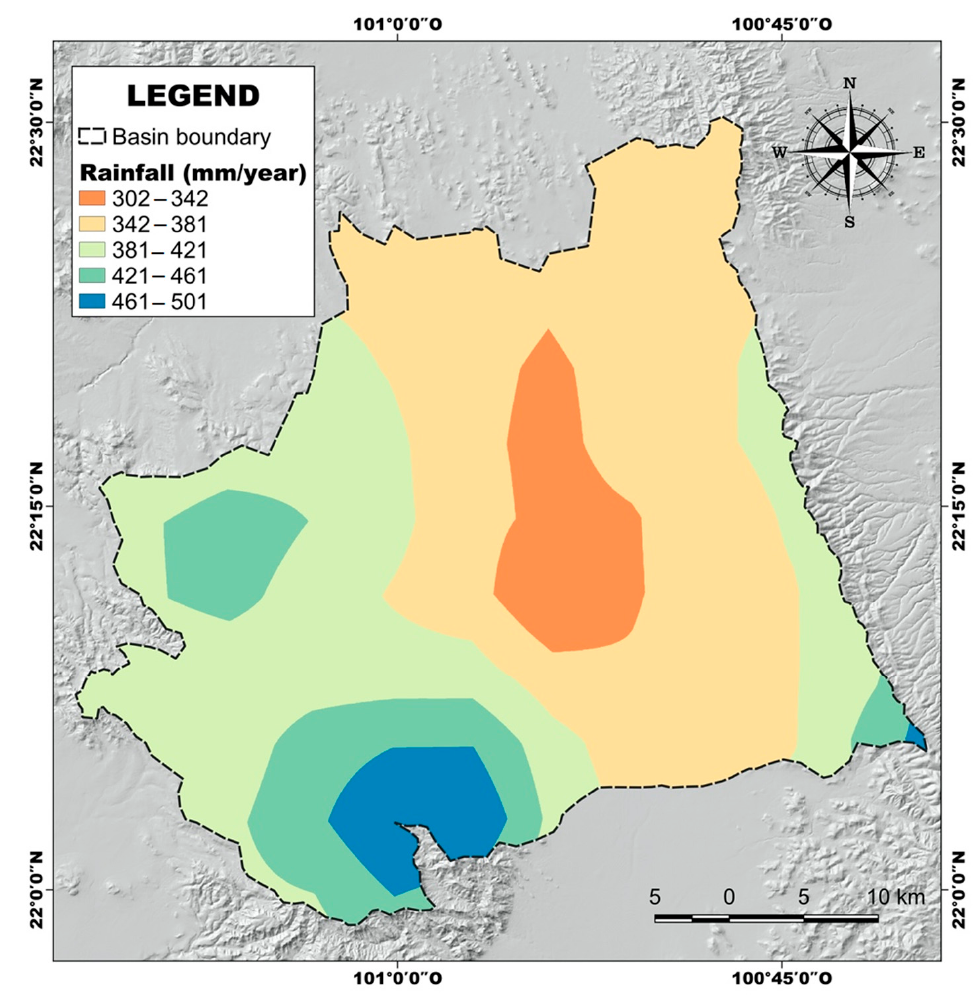
Figure 8. Rainfall map of the San Luis Potosi Basin.